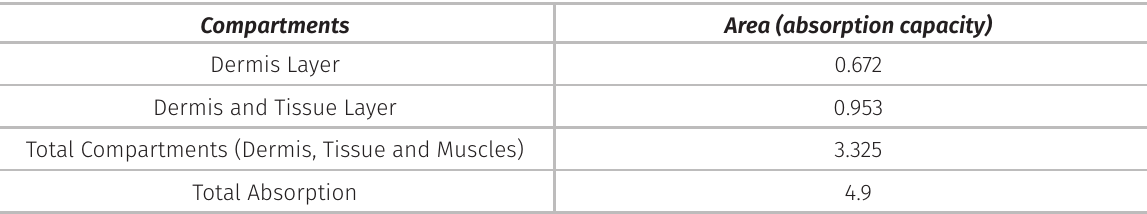
Table IV. Absorption Rate of drug by the